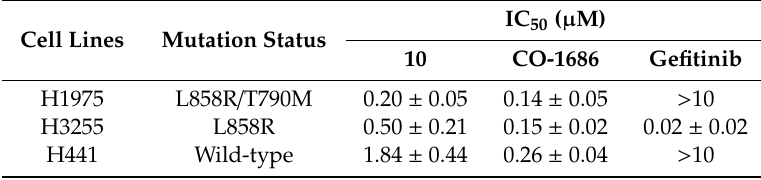
Table 1. The half maximal inhibitory concentration (IC 50 ) after exposure of 10 , CO-1686 or gefitinib to non-small cell lung cancer (NSCLC) cell lines by 2-(2-methoxy-4-nitrophenyl)-3-(4-nitrophenyl)-5- (2,4-disulfophenyl)-2H tetrazolium monosodium salt (WST-8)